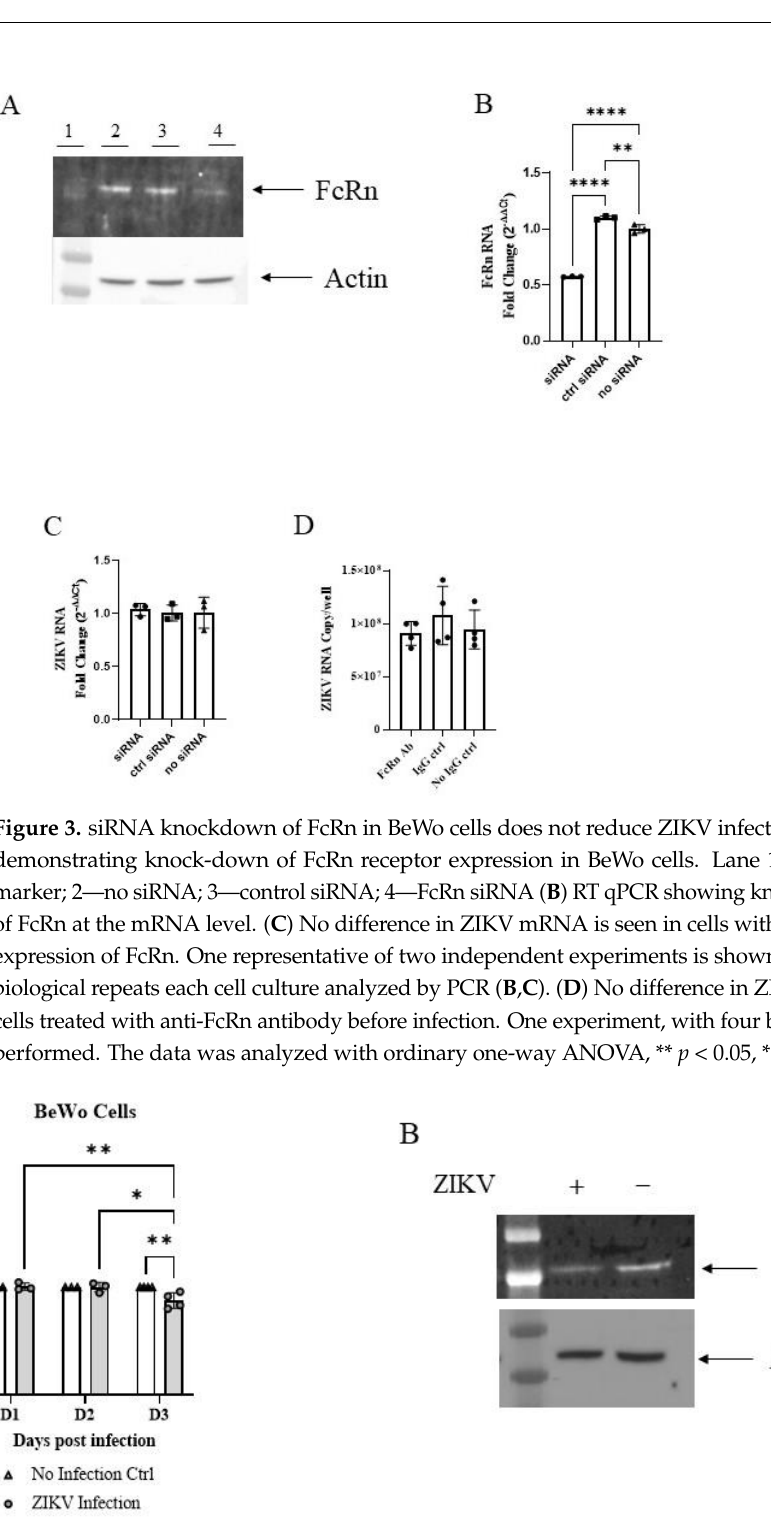
Figure 4. ZIKV infection reduces FcRn expression in BeWo cells. ( A ) Less FcRn mRNA is seen in the three days after ZIKV infection in BeWo cells. The averages from 3-4 independent experiments, with at least three biological repeats for experiment, are shown. ( B ) Less FcRn protein expression is seen three days after ZIKV infection in BeWo cells (three independent experiments, typical image shown). Data ( A ) was analyzed with two-way ANOVA with Tukey’s multiple comparisons test, * p < 0.05, ** p < 0.01. Signal intensities ( B ) for each band were calculated using densitometry (ImageJ) and normalized to respective loading control to allow for comparisons.